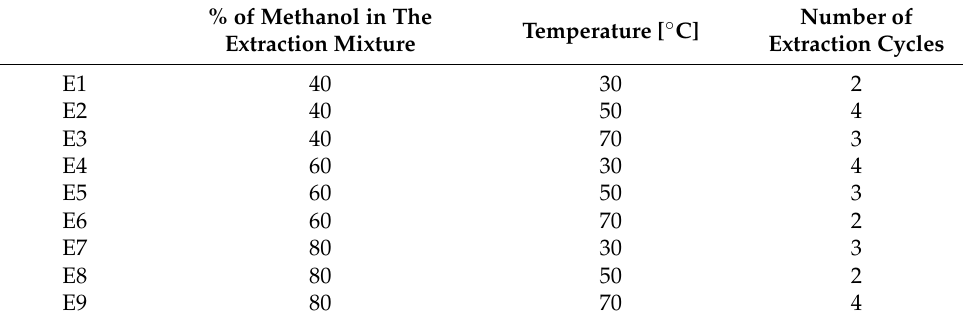
Table 1. Factorial Extraction Process Experiment